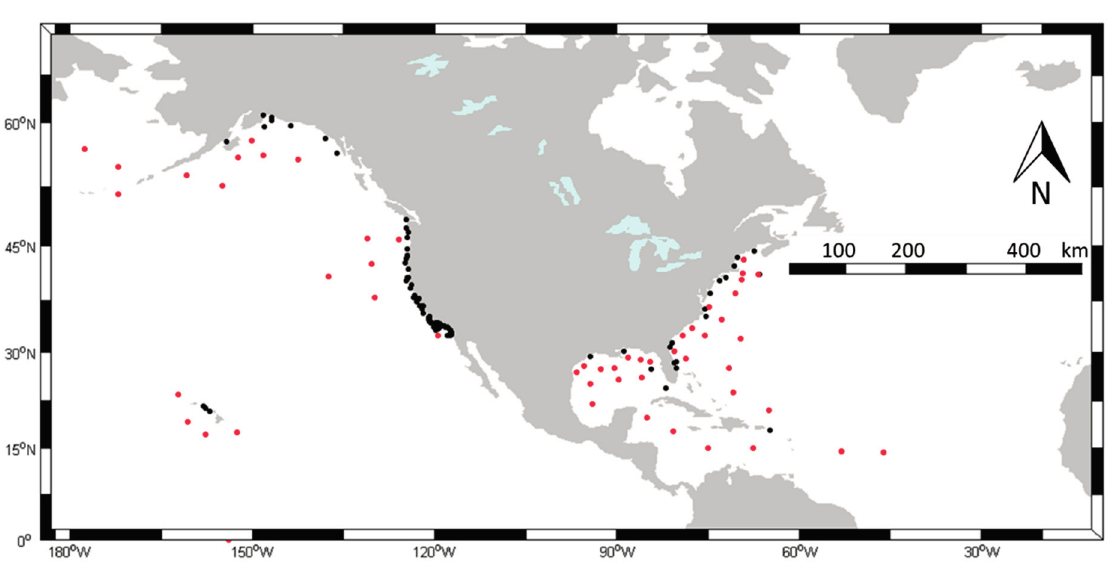
Figure 1 for example. SAR imagettes in Figure 1a,b are inhomogeneous and noisy to detect wave-like pattern, respectively. Only the SAR imagettes with image variance from 1.05 to 1.4, resulting in a rejection rate of 6.5%, such as Figure 1c could be passed the quality control and be used in the triple collocation.